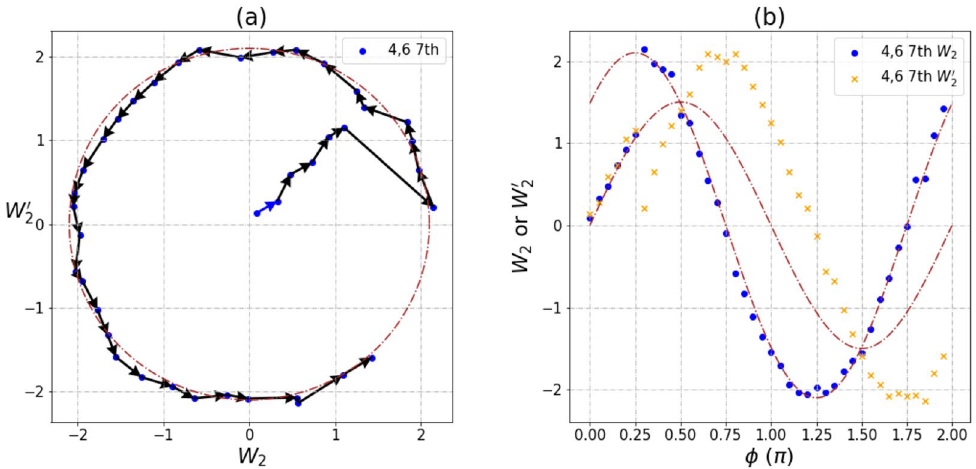
W 2 and (cid:30) (cid:31)